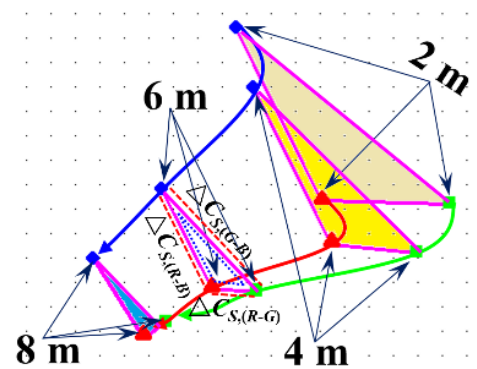
Figure 8. Euclidean distance change and trend of the energy cluster center of the three channels of training samples with the fixation time increased.